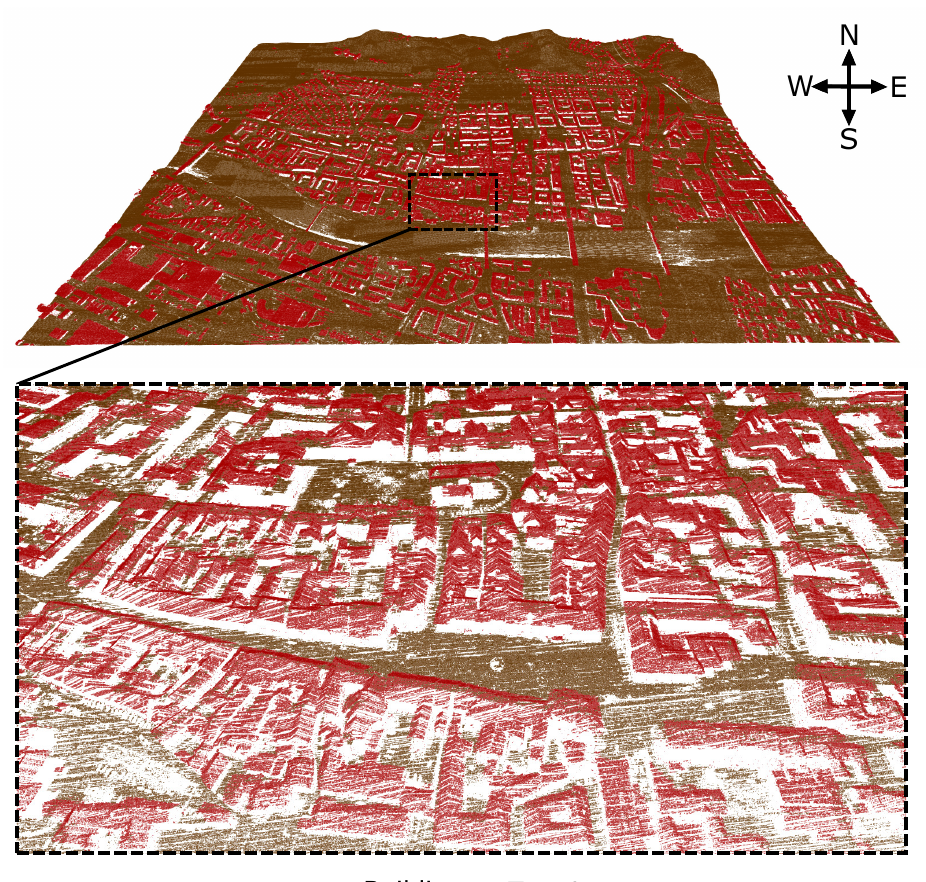
Figure 6. Input LiDAR point cloud.